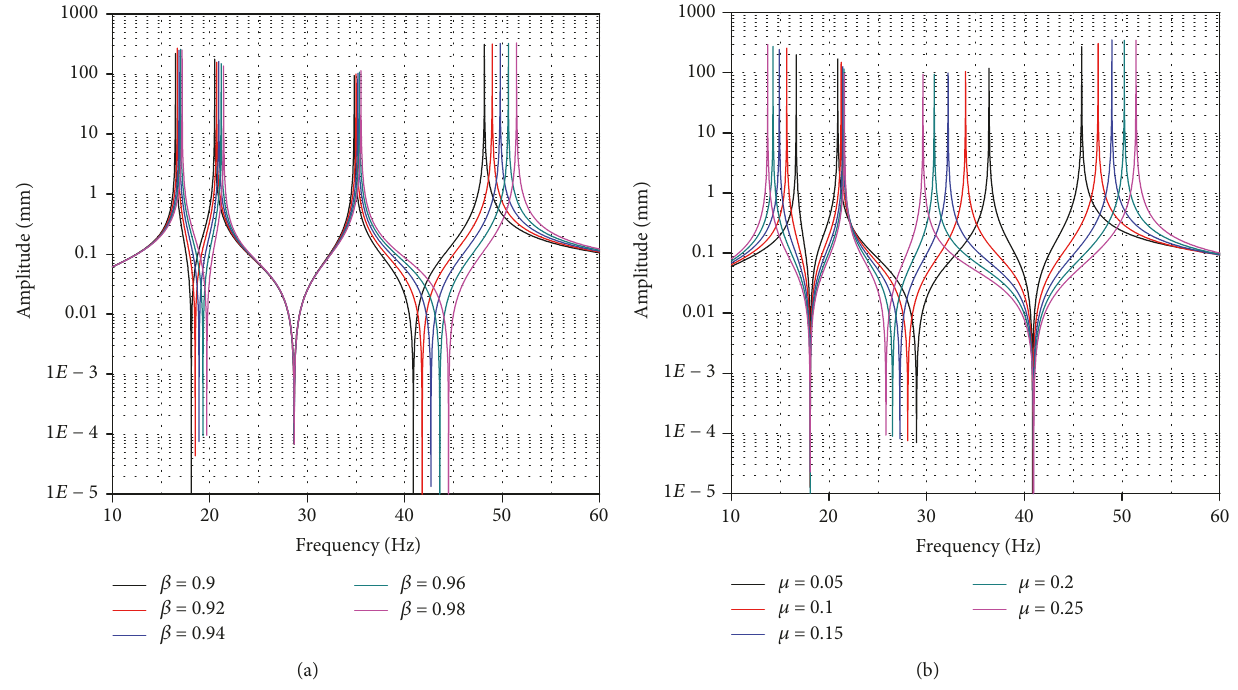
Figure 7: Normalized magnitude of the primary structure: (a) for various 𝛽 values when 𝜇 = 0.1 and (b) for various 𝜇 values when 𝛽 = 0.9